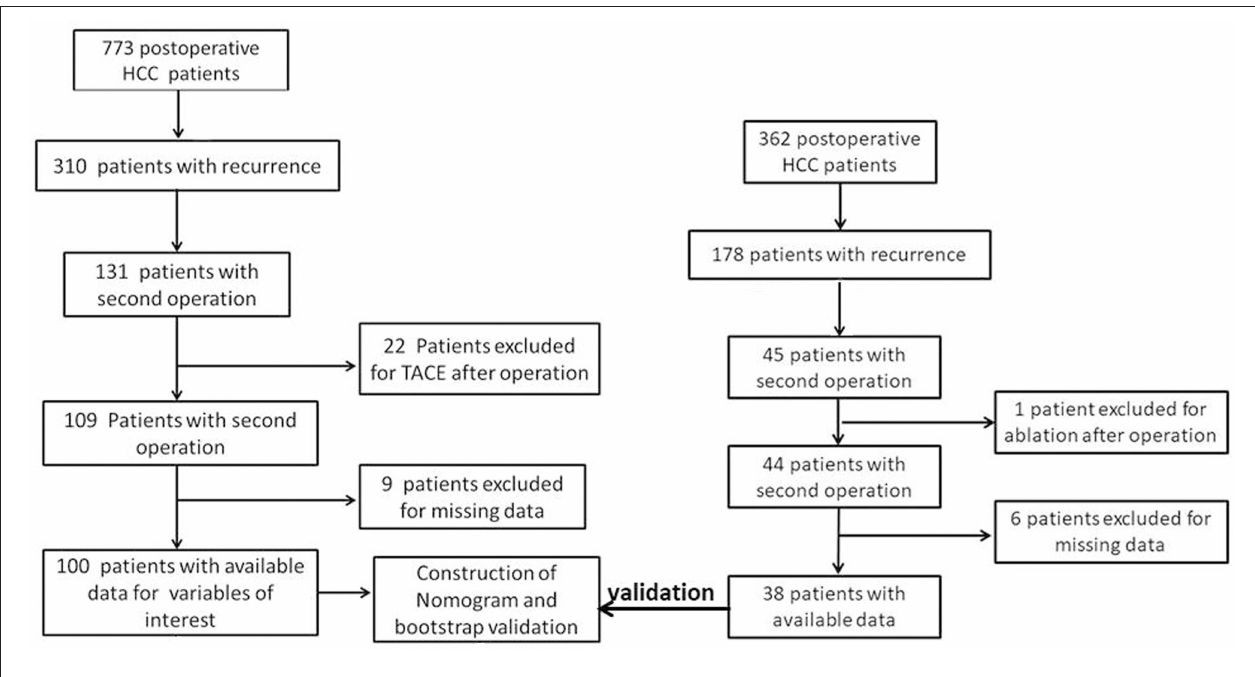
FIGURE 1 | Flowchart of this study.